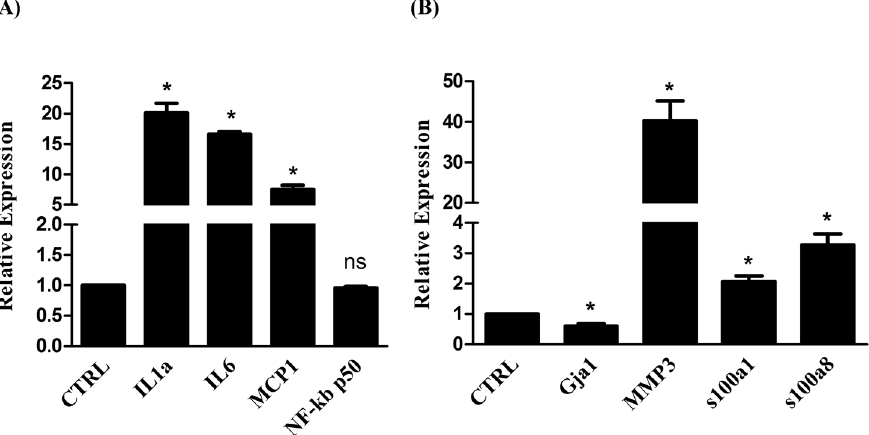
Figure 7. Knockdown ECRG4 affects the expression of genes implicated in inflammation and cardiac remodeling. Knockdown ECRG4 was performed as described in materials and methods and gene expression normalized to GAPDH was expressed as relative expression of the knockdown using Luc-siRNA, which was arbitrarily set as 1. Knockdown ECRG4 significantly increased the expression of IL1a, IL6, and MCP1 ( A , P < 0.05 in all) but not that of NF-kb p50 (ns, non-significant) ( A ), inhibited the expression of Gja1 ( B , P < 0.05) and activated the expression of MMP3, s100a1 and s100a8 ( B , P < 0.05 in all). Data were presented as “Mean ± SD”, and the experiments were performed in triplicate and repeated three